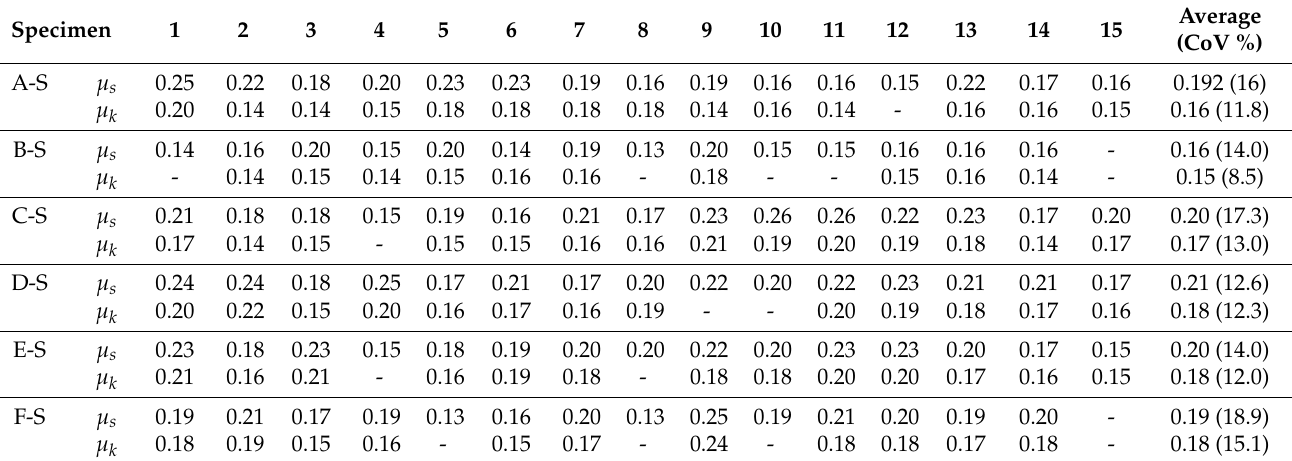
Table 3. Coefficients of friction between timber and steel surfaces depending on the orientation of the contact surfaces and the slip direction (CoV: coefficient of